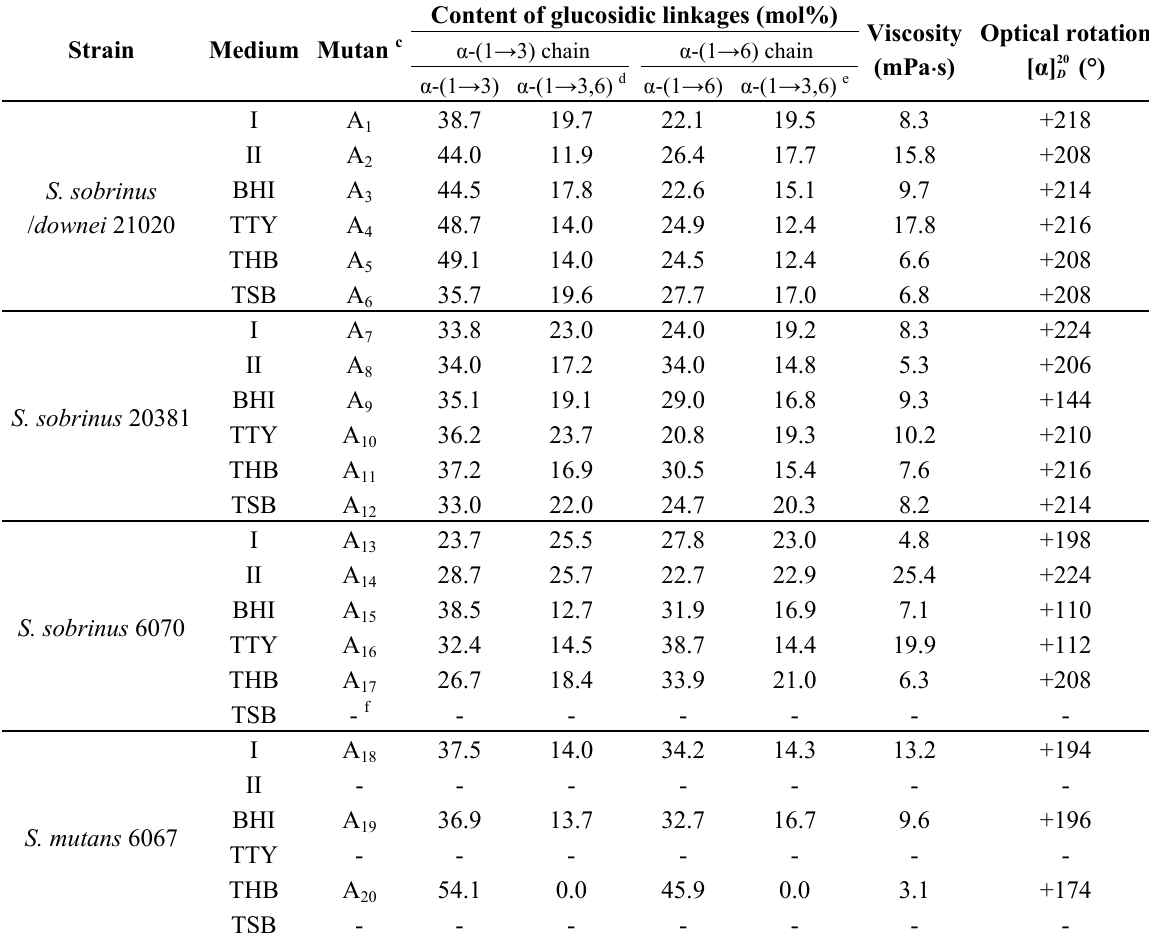
Table 1. Structure and some properties of mutans synthesized by cariogenic streptococcal strains cultivated in various media a,b